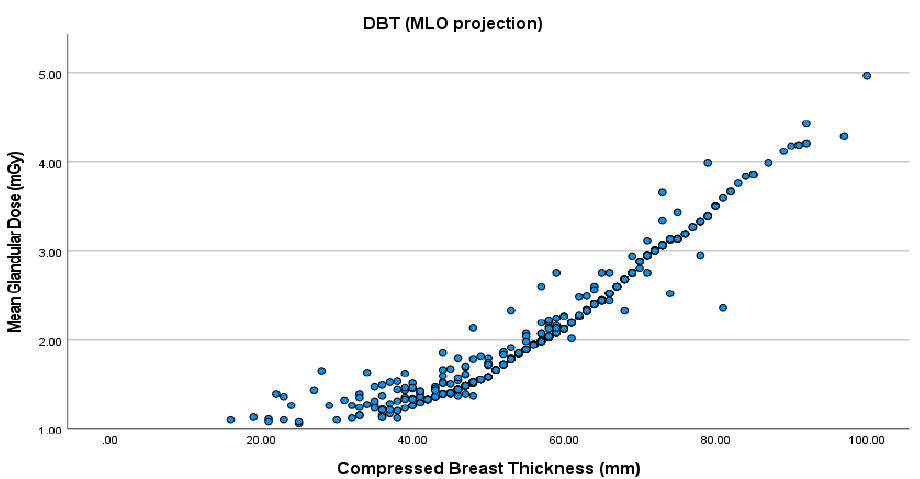
Figure 4. MGD in DBT in the MLO projection. Table 4. The compressed breast thickness (CBT) median in the craniocaudal (CC) and mediolateral oblique (MLO) projections.